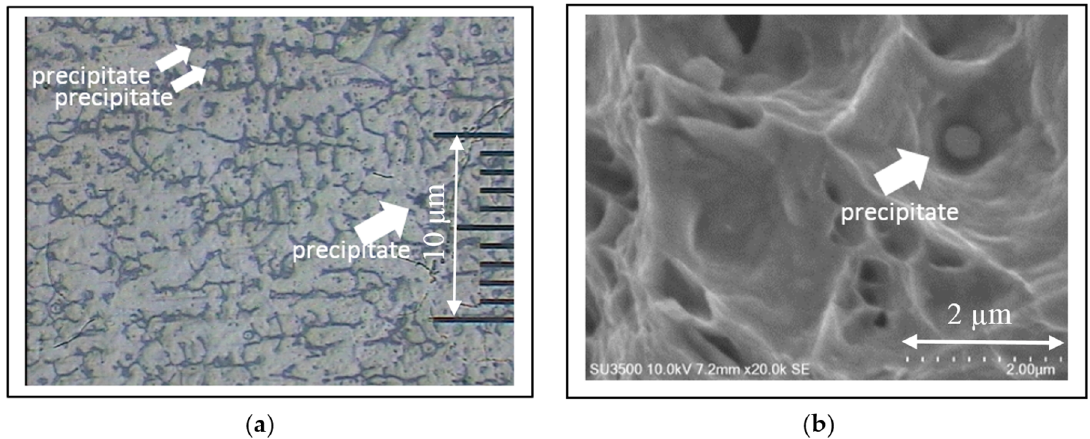
Figure 8. The presence of precipitates. ( a ) precipitate observation by optical microscope magnification = 100; ( b ) precipitate observation by SEM accelerating voltage = 10,000 volts; magnification = 20,000; working distance = 7220 µm.